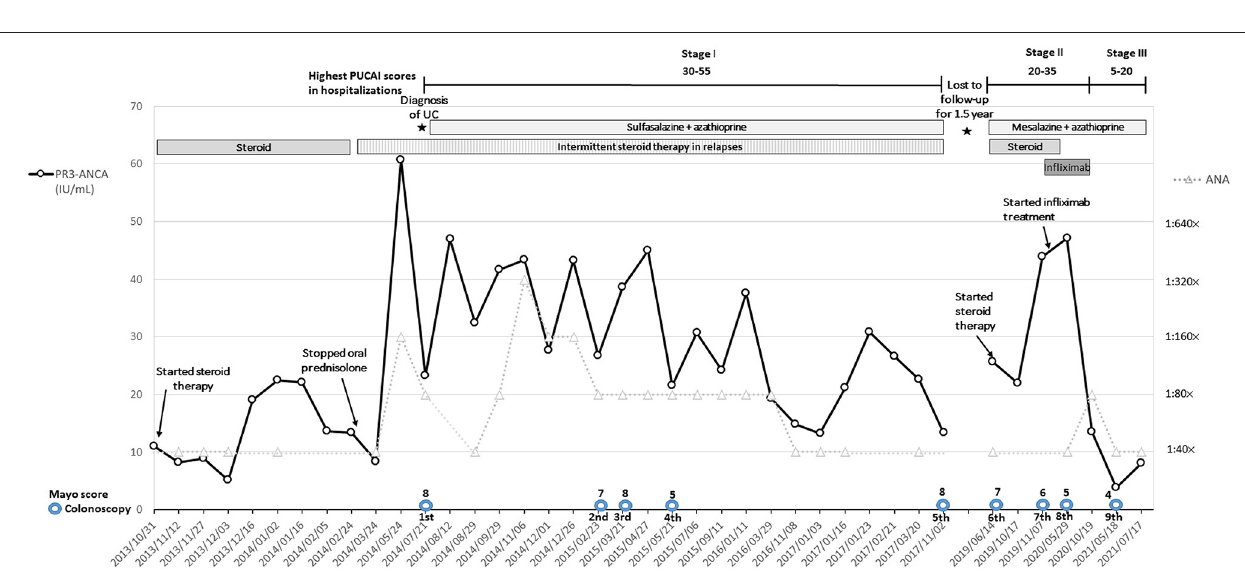
FIGURE 3 | Titers of serum PR3-ANCA, ANA, ranges of highest PUCAI scores during hospitalizations, Mayo scores of nine colonoscopies, and major treatments during the three stages of the entire clinical course. PR3-ANCA titers decreased to a lower range (3.82–13.44 IU/mL, negative < 2.0 IU/mL) with lessened disease activity by lowering highest PUCAI scores (5–20) during hospitalizations after infliximab treatment in combination with continuing azathioprine and mesalazine